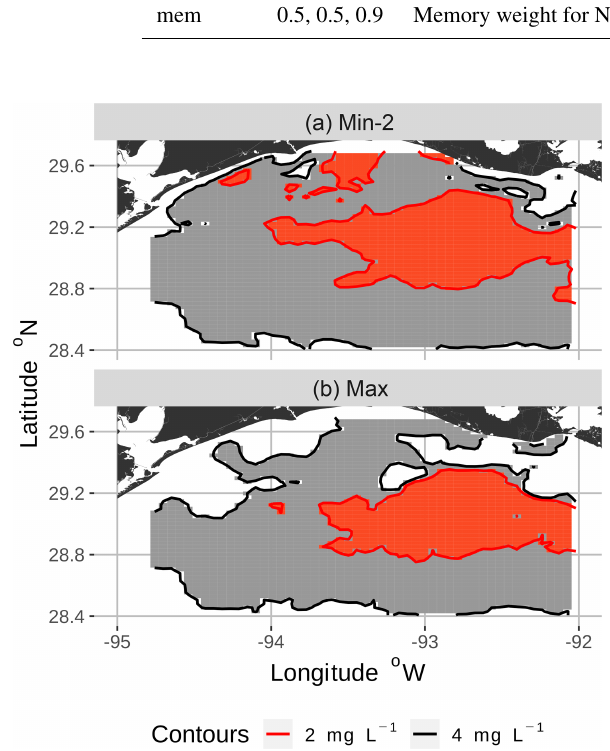
Figure 4. Zoomed-in view of spatial maps of bottom DO showing the 2 and 4mgL − 1 contours for two of the eight snapshots from the FVCOM-WASP simulation of 20–30 August 2002. The snapshots are defined in Table 1. Snapshot Min-2 ( a ; row 2 in the Table) is moderate sublethal area and minimum AUC, and snapshot Max ( b ; row 8 in the Table) is high sublethal area and maximum AUC. Areas in white outside the 4mgL − 1 line are